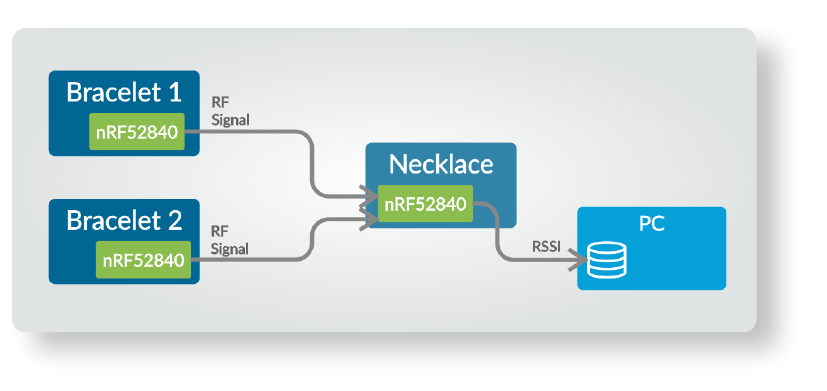
Figure 2. WBAN system architecture. It consists of two BLE wireless modules placed on the wrists (Bracelet 1 and Bracelet 2) and one coordinator module placed in a necklace. The measured RSSI signals can be classified externally (in a mobile phone or PC) by the